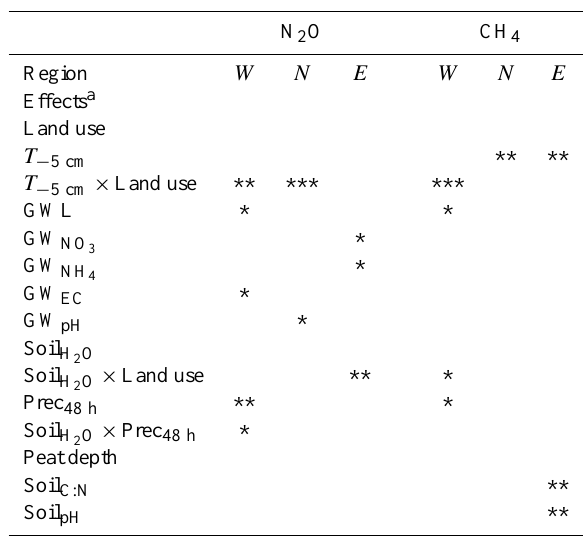
Table 7. Relationships between soil and environmental conditions and, respectively, CH 4 and N 2 O fluxes during the monitoring period were investigated with a linear mixed model. Methane fluxes were square-root transformed, and N 2 O fluxes ln transformed, prior to testing. See text for an explanation of the independent variables and interactions included in the